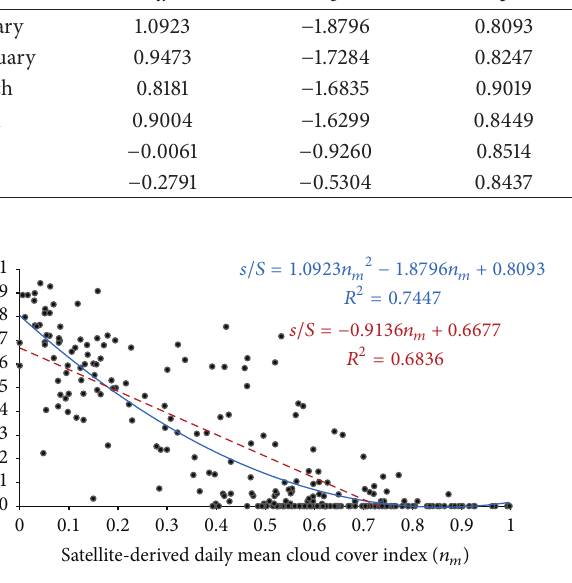
Figure 2: Quadratic and linear relationships between daily frac- tional sunshine hours and satellite-derived daily mean cloud cover index using data of nine calibration stations for January